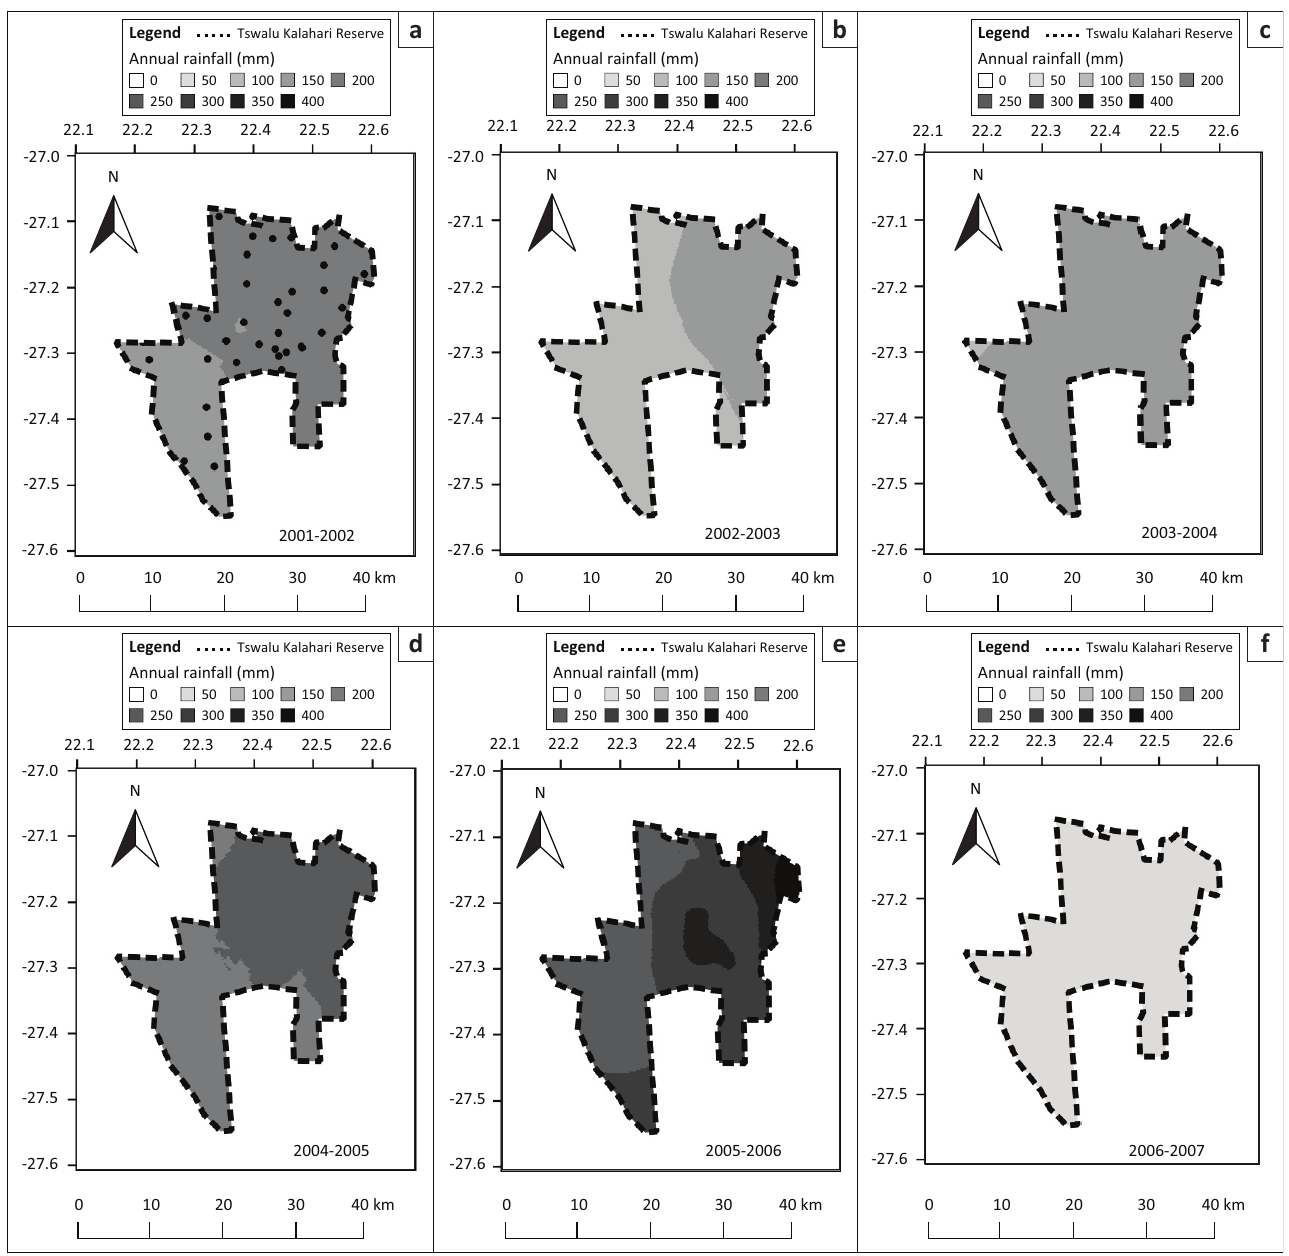
FIGURE 4: A composite of interpolated annual rainfall surface contour maps computed by ordinary kriging for the growth seasons (October to September) in the Tswalu Kalahari Reserve. Black dots in the 2001–2002 map represent the locations of the rainfall stations. (a) 2001–2002, (b) 2002–2003, (c) 2003–2004, (d) 2004–2005, (e) 2005–2006, (f) 2006–2007, (g) 2007–2008, (h) 2008–2009, (i) 2009–2010, (j) 2010–2011, (k) 2011–2012, (l) 2012–2013 and (m)